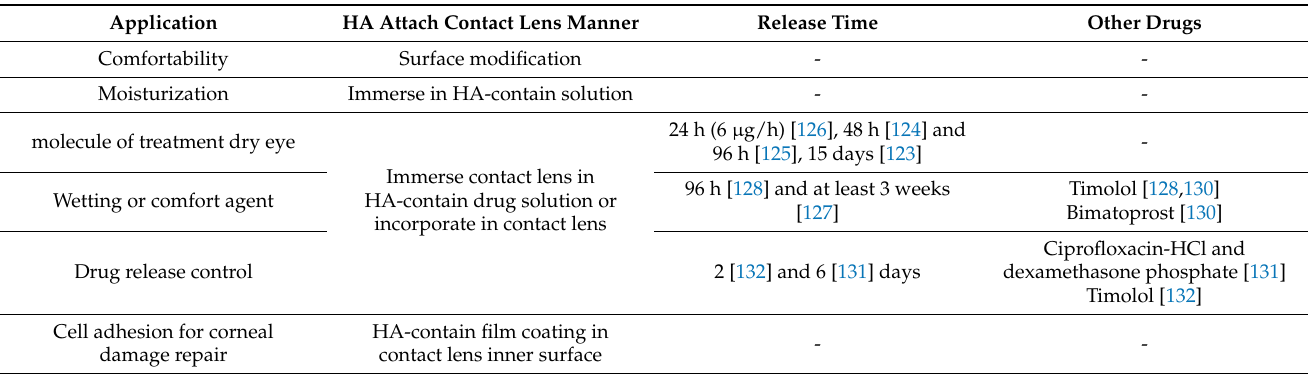
Table 3. Applications of HA on Contact